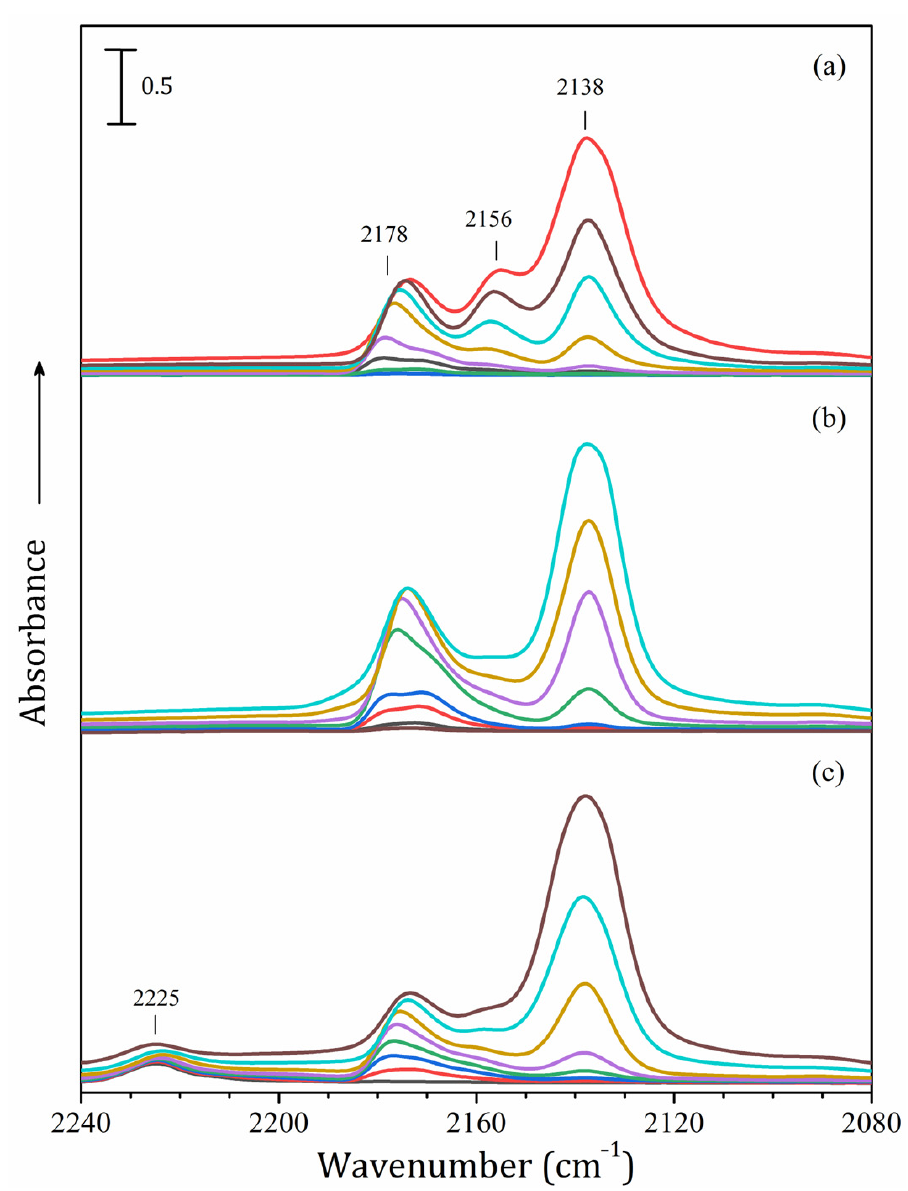
Figure 8. Evolution of FTIR spectra of CO adsorbed on HMOR-15.0 pretreated at 300 ◦ C ( a ), 450 ◦ C ( b ), and 600 ◦ C ( c ), in course of desorption. Spectra are registered at − 196 ◦ C in the presence of ca 0.5 torr of helium.